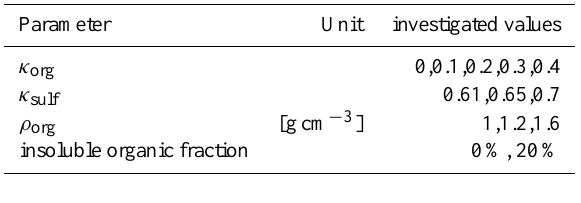
Table 2. Table with the different parameter values for the performed closure studies. For a detailed listing of the different permutations, see Table A1.